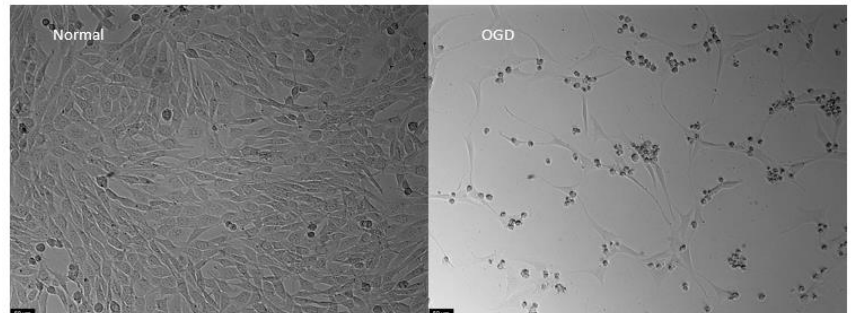
Figure 13. Representative images of HT-22 cells morphology, both under normal or Oxygen-Glucose Deprivation conditions during 48 h. Images of cell morphology were obtained using a Leica microscope equipped with Leica LAS X imaging software v3.7.4 (Leica Microsystems, Wetzlar, Germany). Scale bar: 50 µm. Morphological Analysis of HT-22 Cells after 6 and 48 h of Treatment with Edaravone, Perampanel, and Metformin under Oxygen Glucose Deprivation Submission